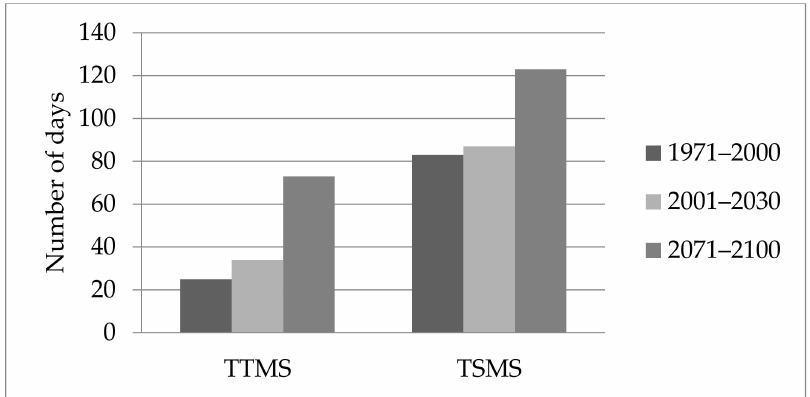
Figure 2. The total number of tropical (TTMS) and summer days (TSMS) over the baseline period (1971–2000) and in the projected climate scenarios (2001–2030 and 2071–2100).